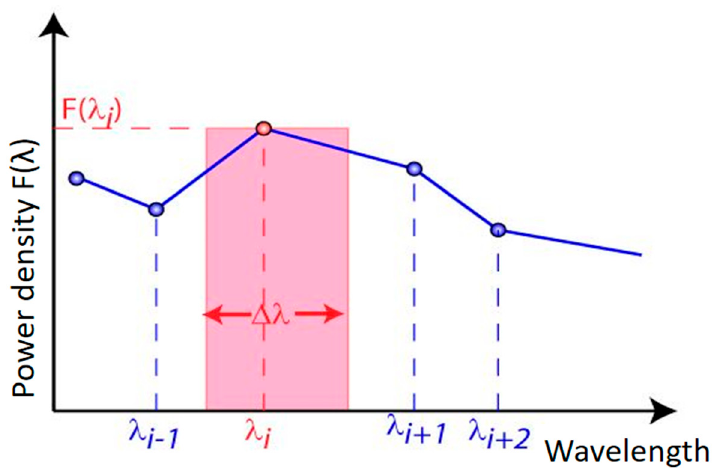
Figure 2. The schematic picture of power density (intensity) averaging technique. (All units in arbitrary).